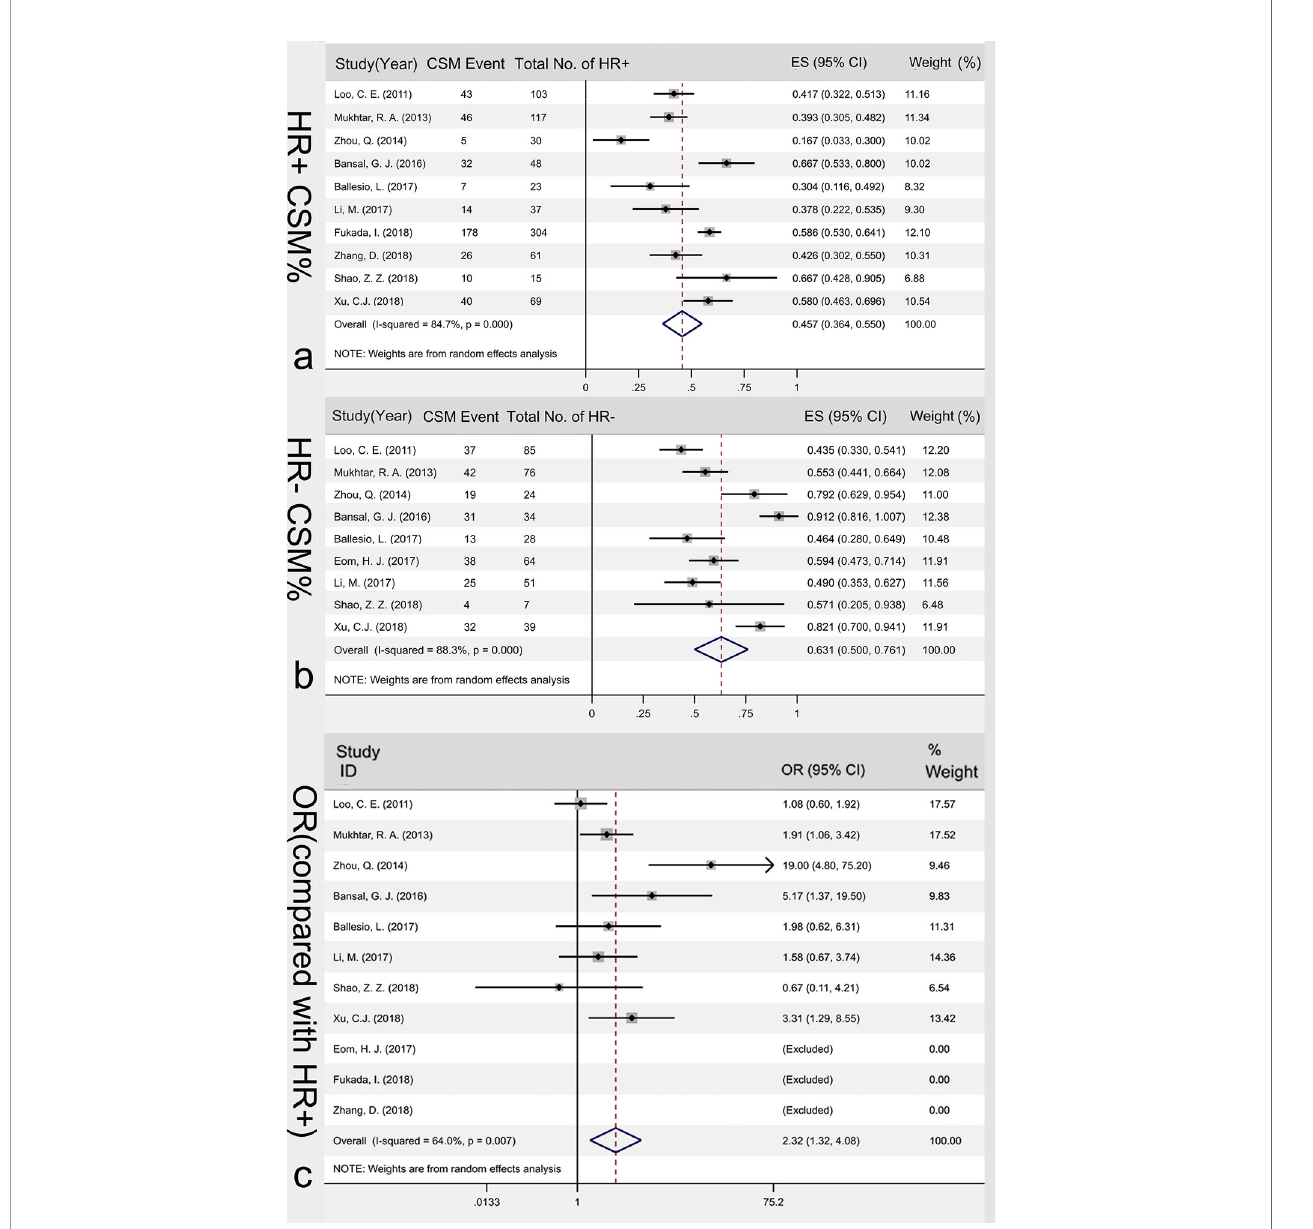
FIGURE 5 | Association of HR hormonal receptor and CSM%. HR+ CSM% (A) , HR- CSM% (B) and the OR value between HR- CSM% and HR- CSM% (C) . CSM, concentric shrinkage mode; HR+, hormone receptor positive; HR-,hormone receptor negative; OR, odds ratio; ES, effect